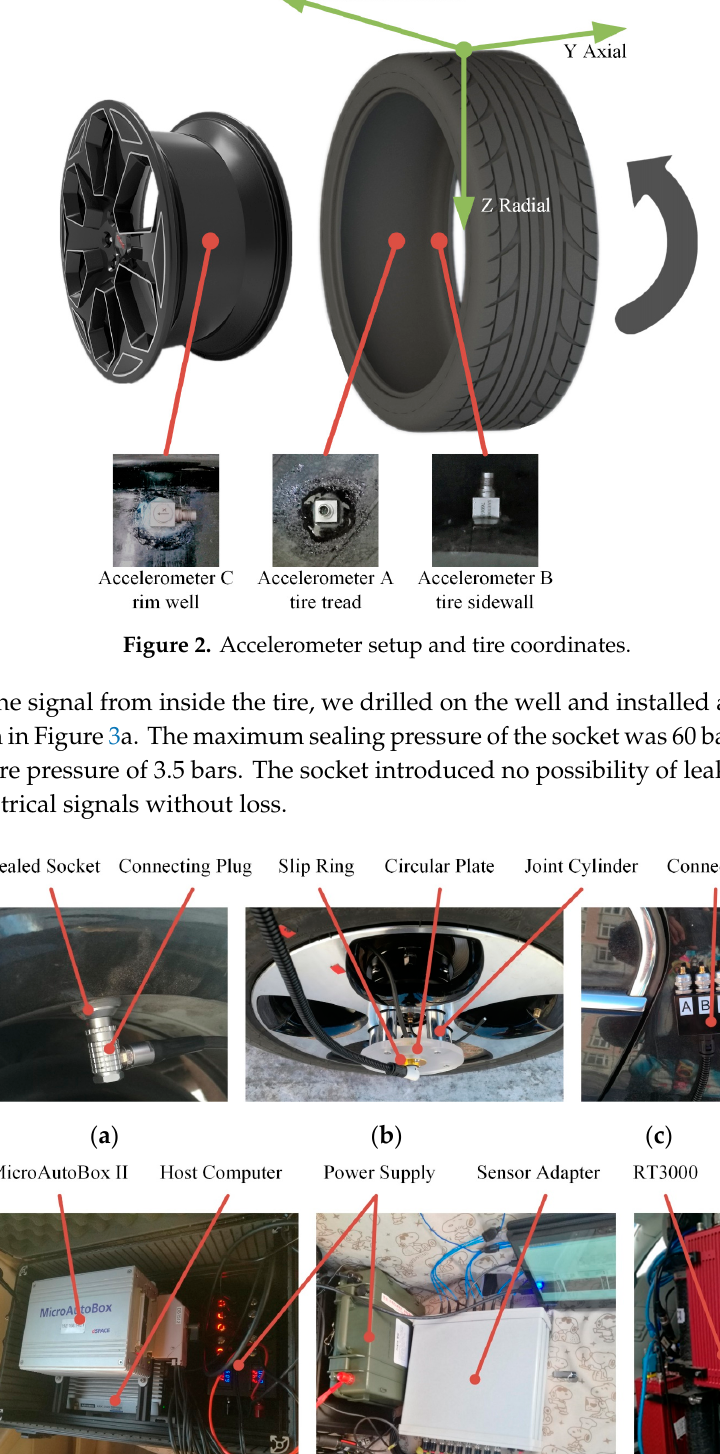
Figure 2. Accelerometer setup and tire coordinates.